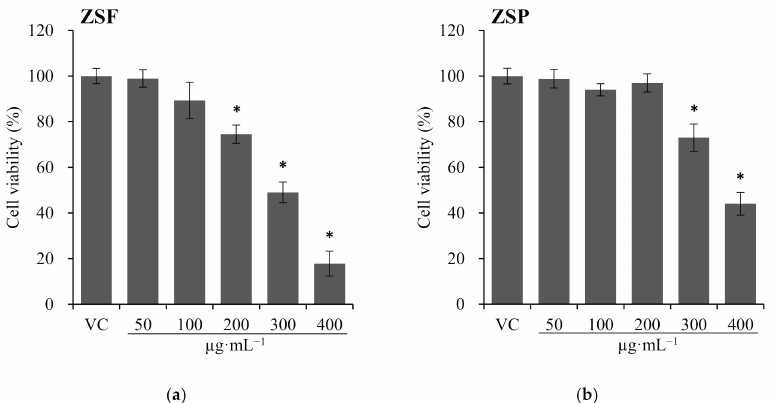
Figure 3. Effects of Zanthoxylum schinifolium extracts (( a ) ZSF: Z. schinifolium fruit extract, ( b ) ZSP: Z. schinifolium pericarp extract) on WI-38 cells viability for 24 h. Data are expressed as the mean ± SD of triplicate experiments. * Significant difference compared with the vehicle control group ( t -test, * p < 0.0201). VC, vehicle control (DMSO).